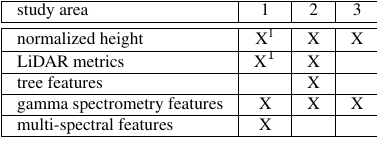
Table 2. Available feature subsets in the study areas